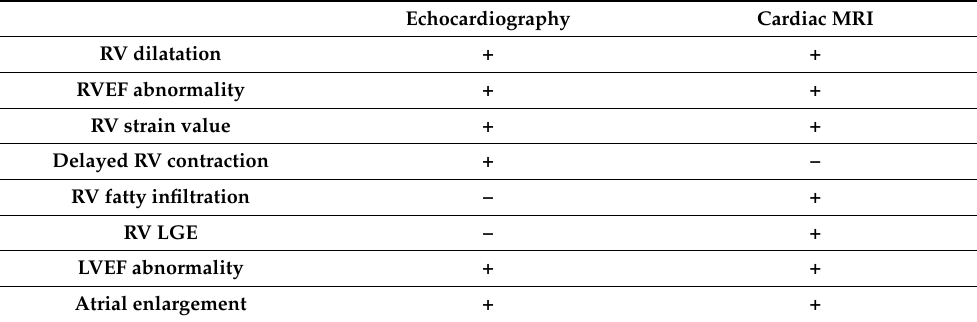
Table 1. Main abnormalities detected by imaging techniques in Brugada Syndrome